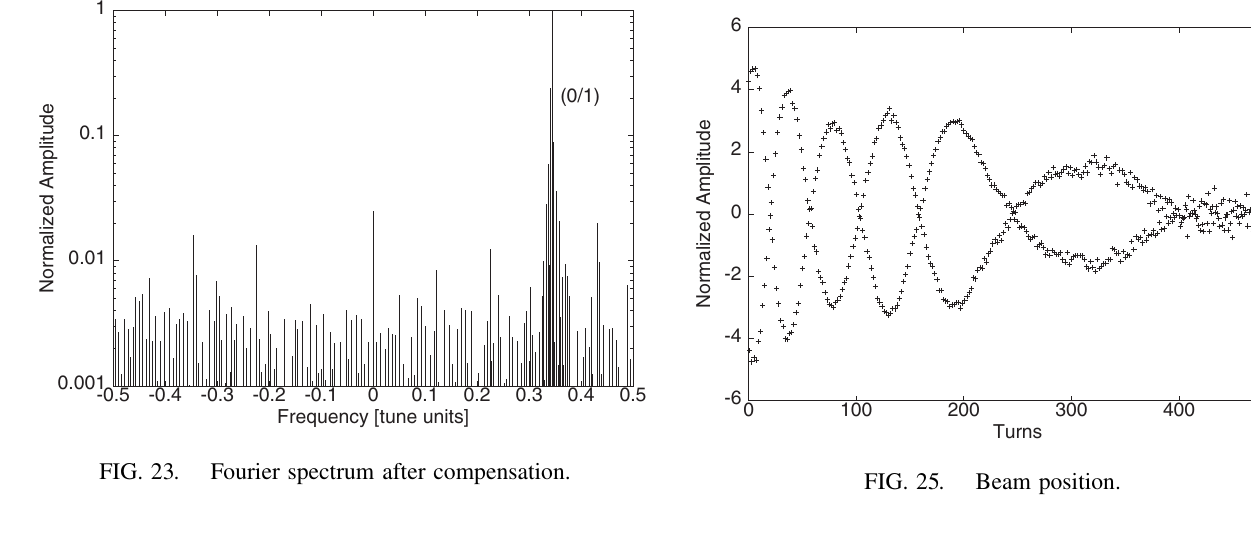
FIG. 23. Fourier spectrum after